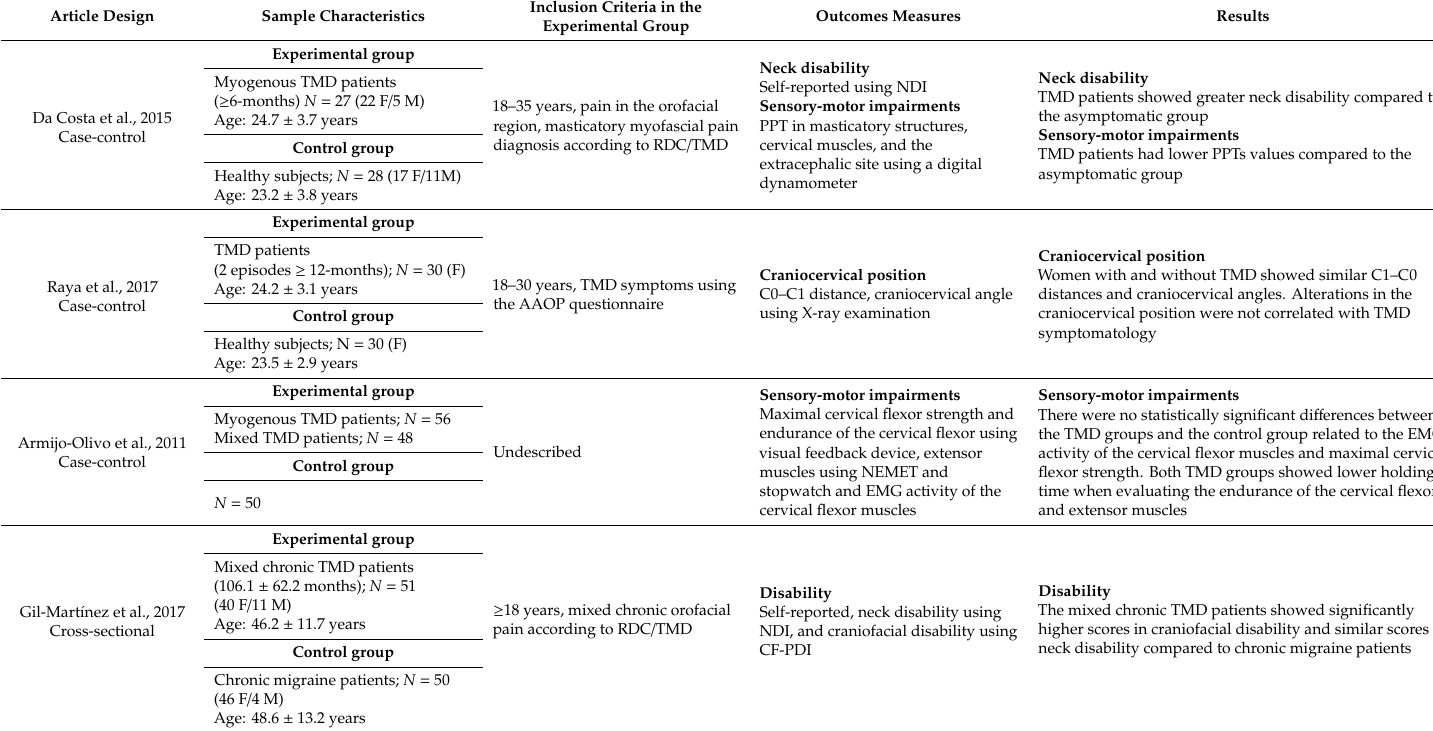
Table 1. Characteristics of included